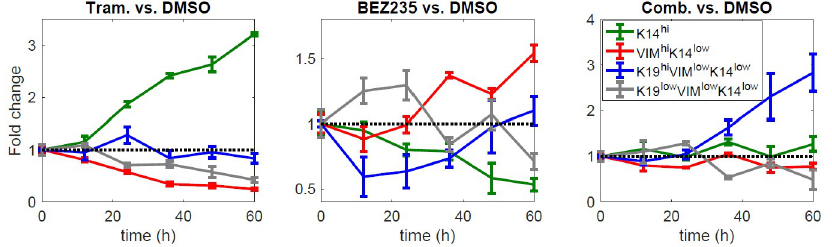
Fig 7. Differentiation-state time series portion of the test data. The sample mean and the sample standard deviation of fold change for each differentiation state are shown at each time point, computed from 4 samples. Fold change is fraction differentiation state i ; well w ; time k ; therapy , where fraction differentiation state i is the number of cells counted in that state average fraction differentiation state i ; time k ; DMSO divided by the population